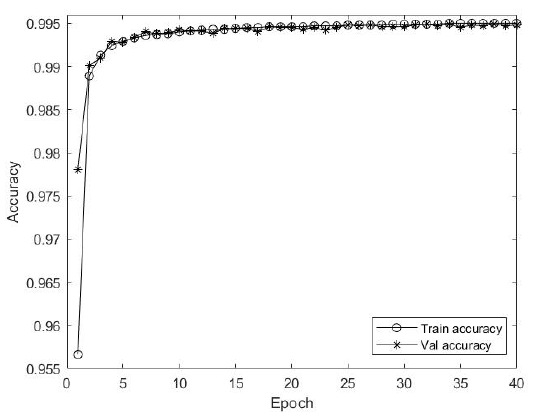
Figure 8. The loss curves of PFSegIris on the mixed iris training set and validation set.